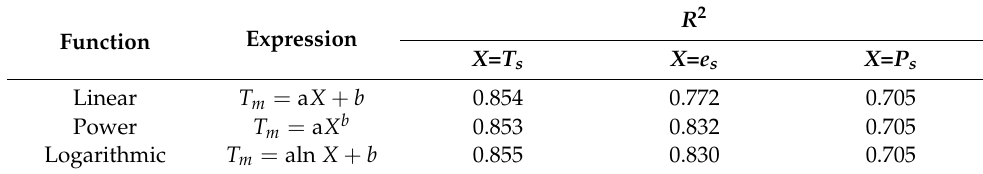
Table 2. The fitting indexes ( R 2 ) of T m − T s , T m − e s and T m − P s